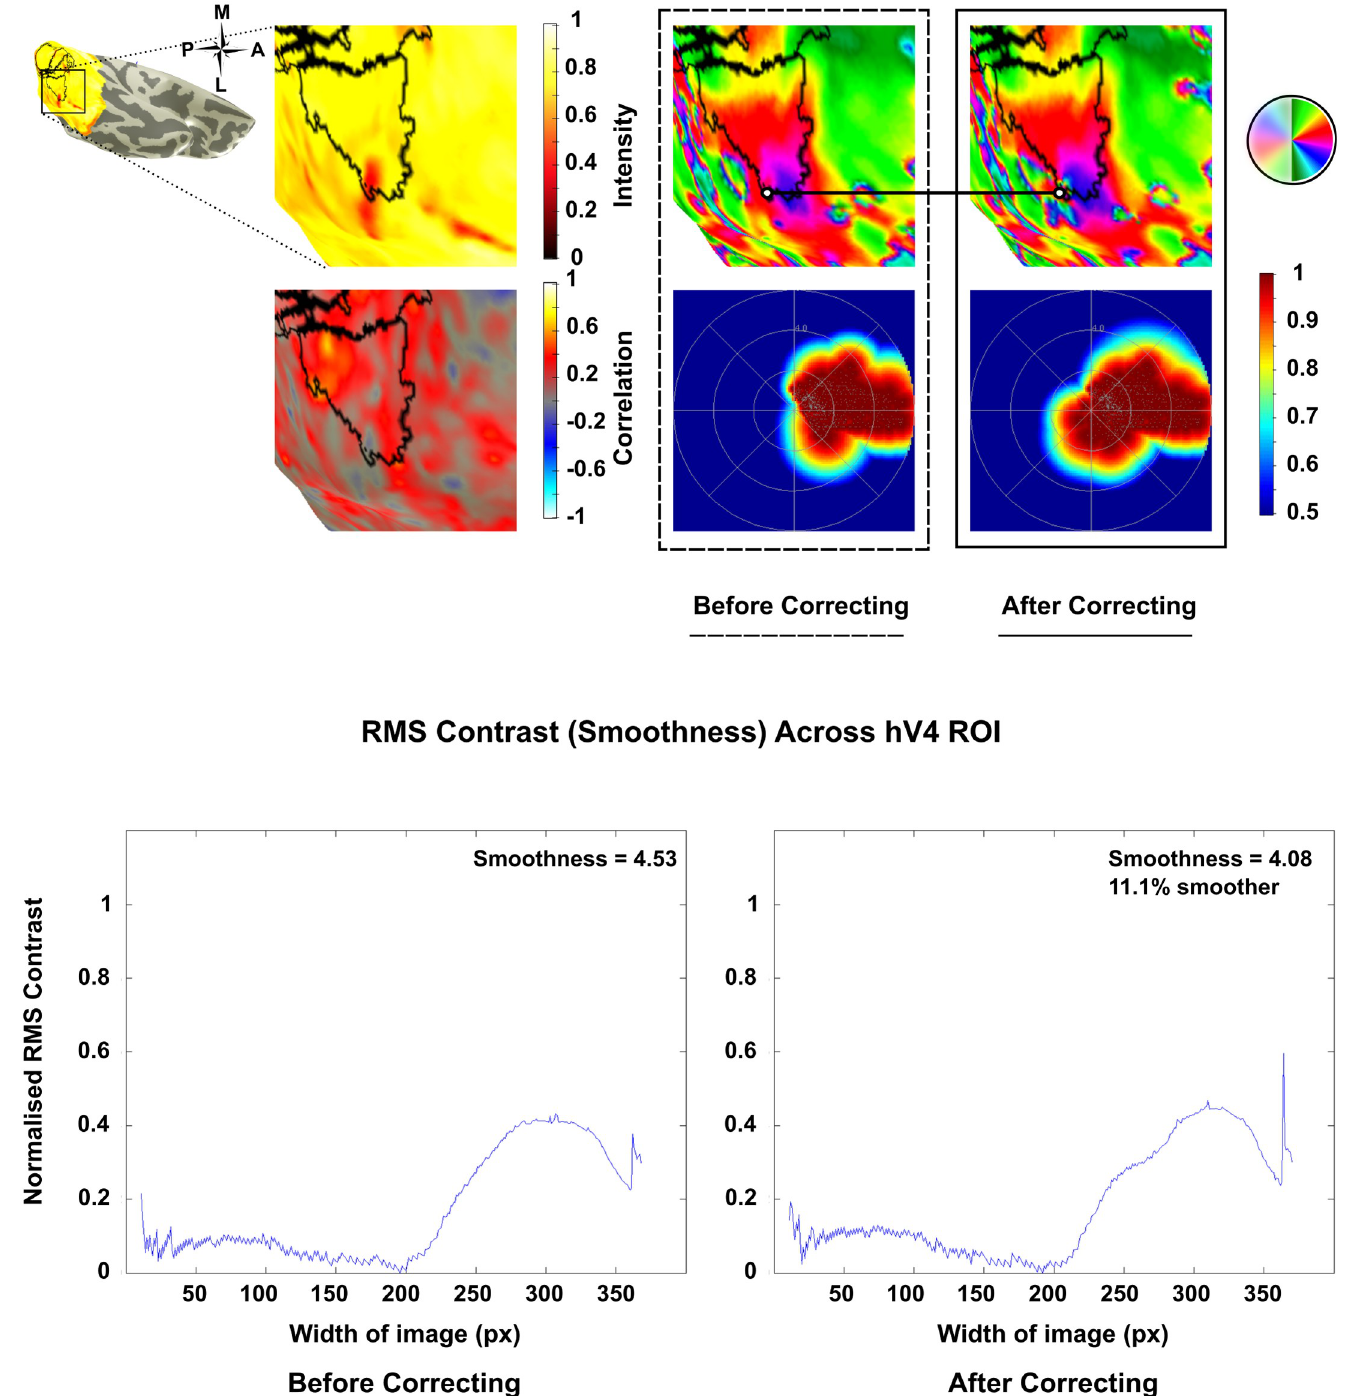
Fig 7. Coverage in the lower quadrant of Subject 3 (LH) increased from 19.1% to 25.8% post correction. Polar angle mapping shows minimal changes and improvements in map smoothness post correction are inconsequential. Regions of improvement are highlighted by the white